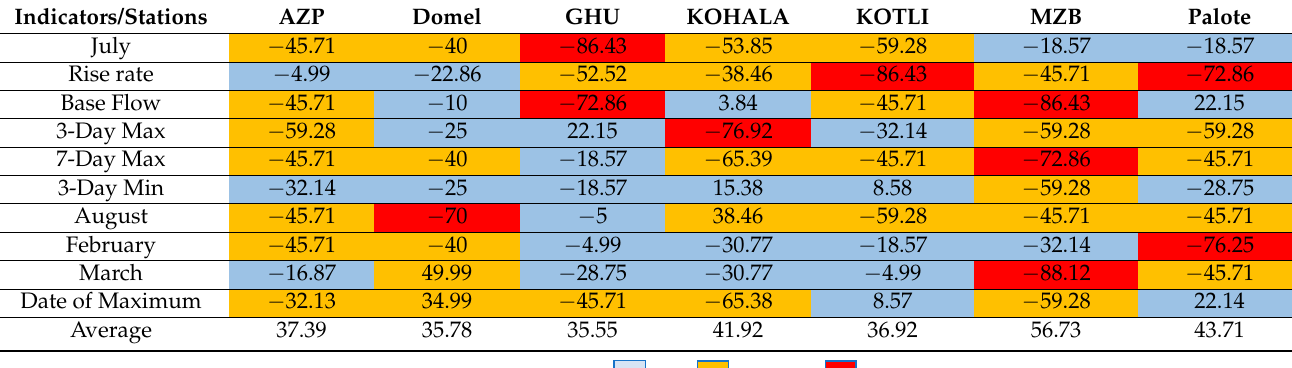
Figure 8. Spatial indicators of Hydrological Alteration.